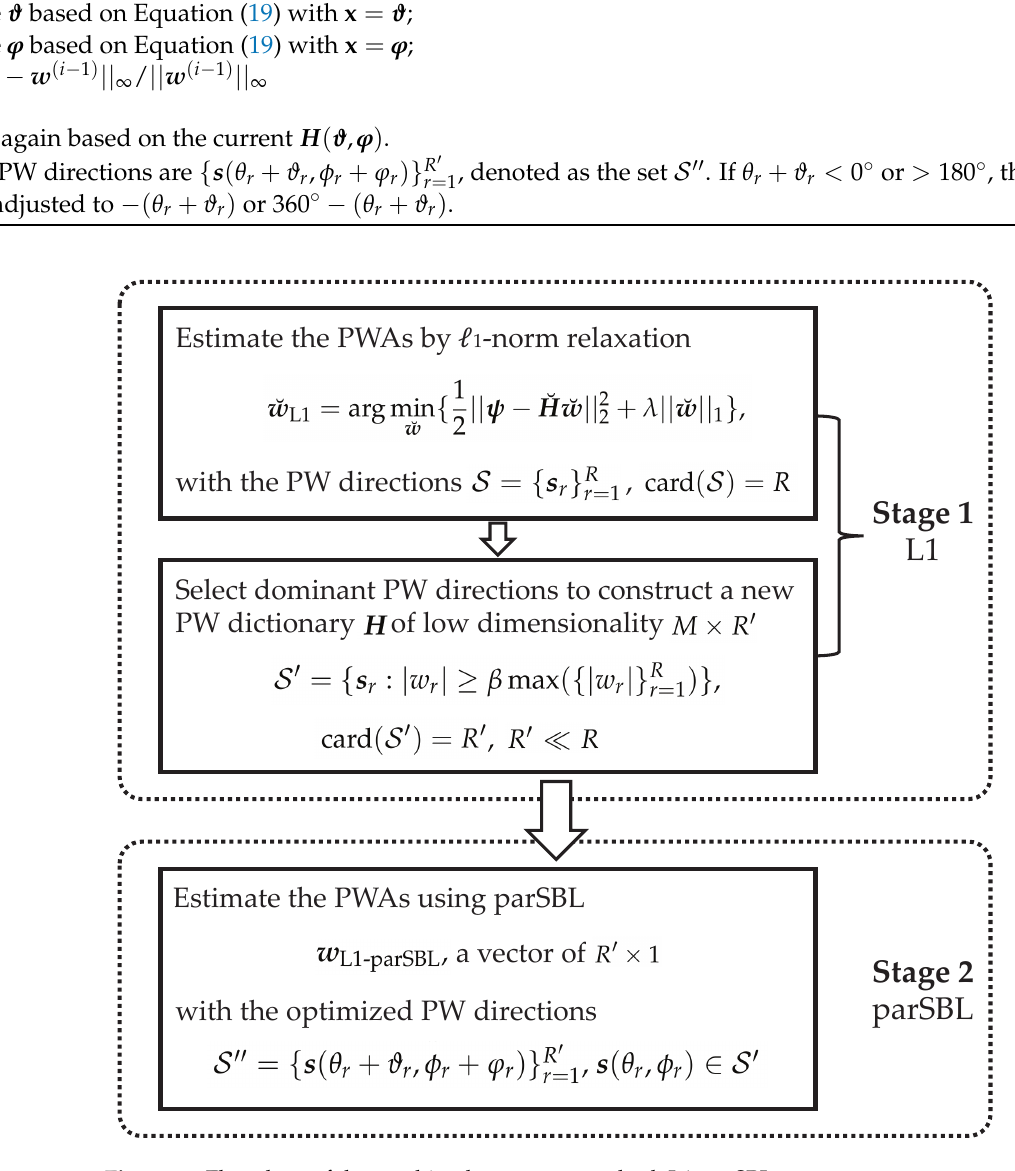
Figure 2. Flowchart of the combined two-stage method,